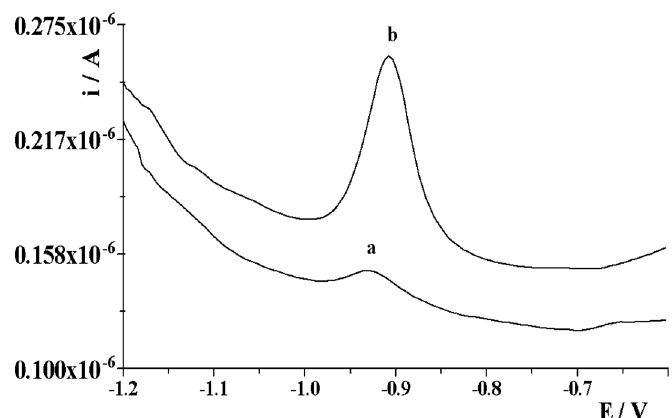
Figure 4. Exemplary voltamperograms recorded for 2 × 10 − 7 mol L − 1 Ga(III) using as working electrode: solid bismuth microelectrode without activation (a); solid bismuth microelectrode with activation (b).